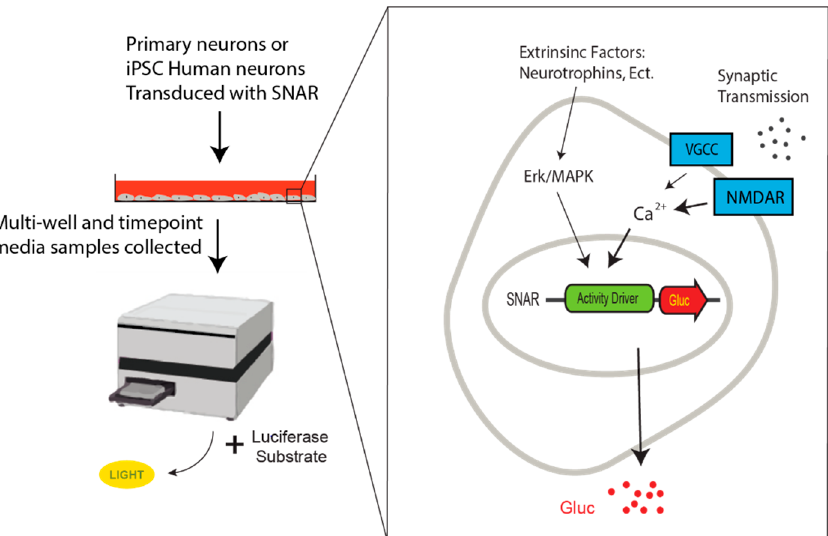
Figure 2. Schematic of secreted neuronal activity reporter (SNAR) assay. Human iPSC-derived neurons or primary neuron cultures are transduced with SNAR. Media samples are collected at multiple time points and luciferase activity is recorded after the addition of the Coelenterazine, the Gaussia luciferase substrate by a luminometer. SNAR is calcium dependent and predominantly induced by NMDA receptor activation. Voltage gated calcium channels (VGCC) as well as the Erk/MAPK pathway also contribute to SNAR, albeit to a lower